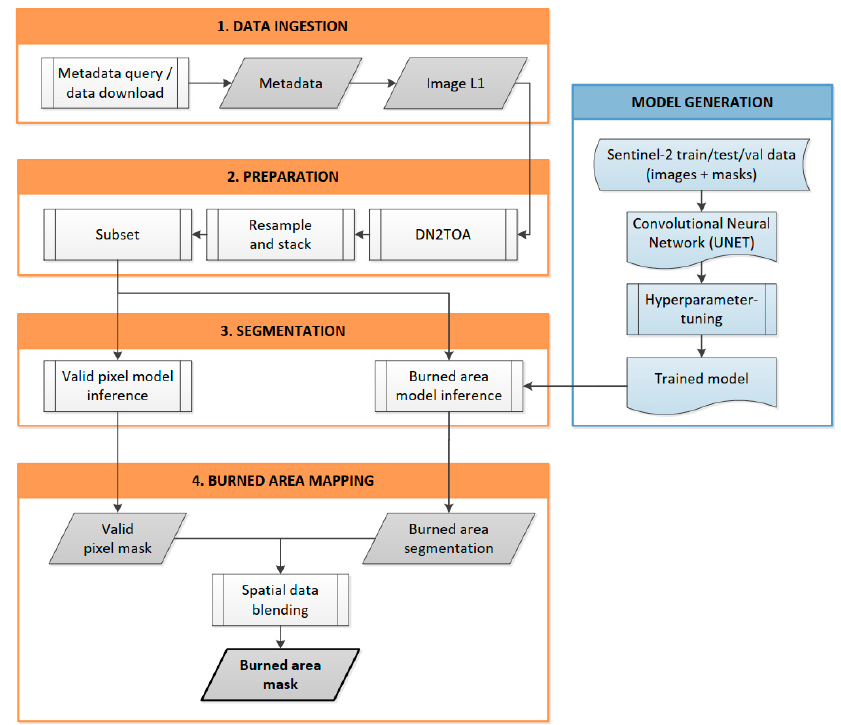
Figure 3. Basic workflow to automatically map burned areas with Sentinel-2 data, including data ingestion, data preparation, segmentation and final burned area mapping. The focus of this work is on the model generation component for burned area segmentation (highlighted in blue).